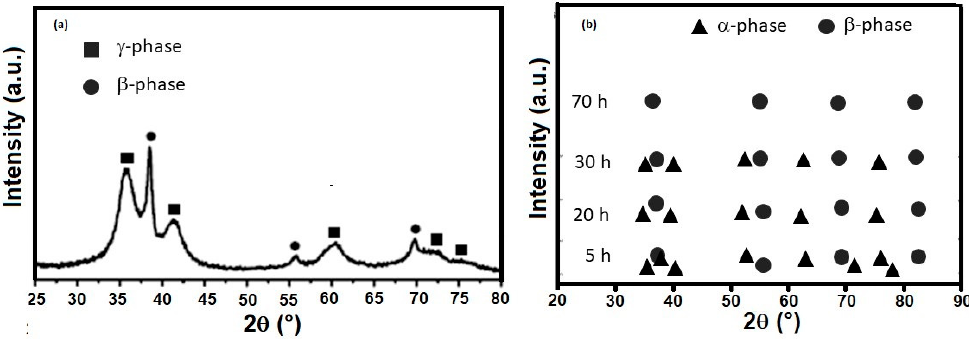
Figure 5. XRD patterns of ( a ) the Ti-30Nb-13Ta [32] alloy milled at 60 h and ( b ) the Ti-20Nb-30Ta alloy milled at di ff erent milling times adapted from